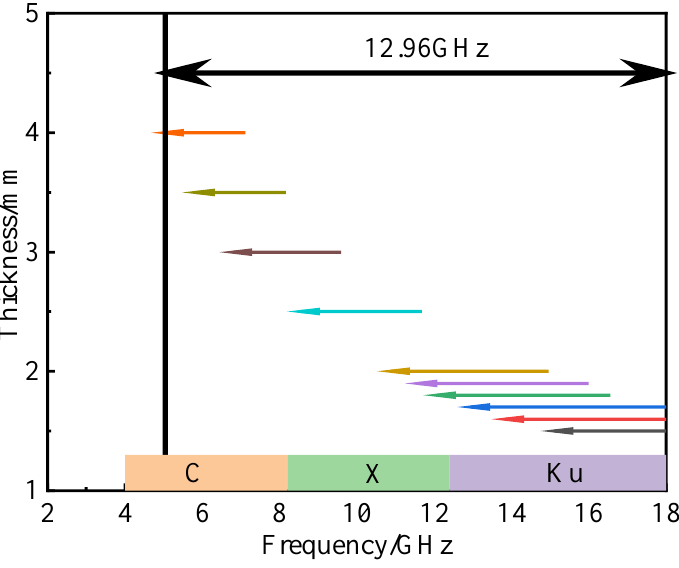
Figure 7. Effective absorption bandwidths of the CB20 − CIP30 composite at different thicknesses.